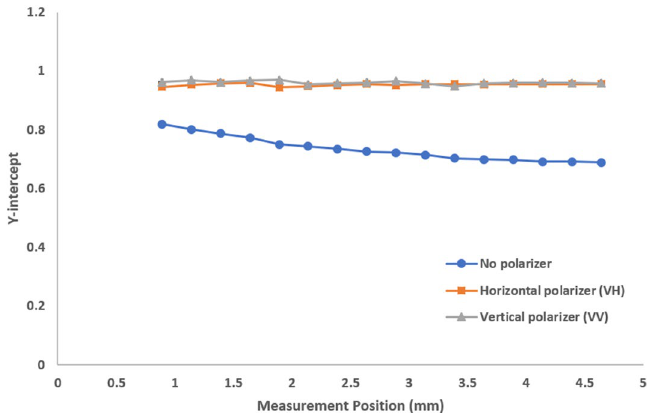
Figure 9. Y-intercept as a function of measurement position for stock milk showing increased presence of multiple scattering away from the cuvette wall. For reasonable scattering intensity, any polarizer detection will lead to a near-perfect intercept approaching